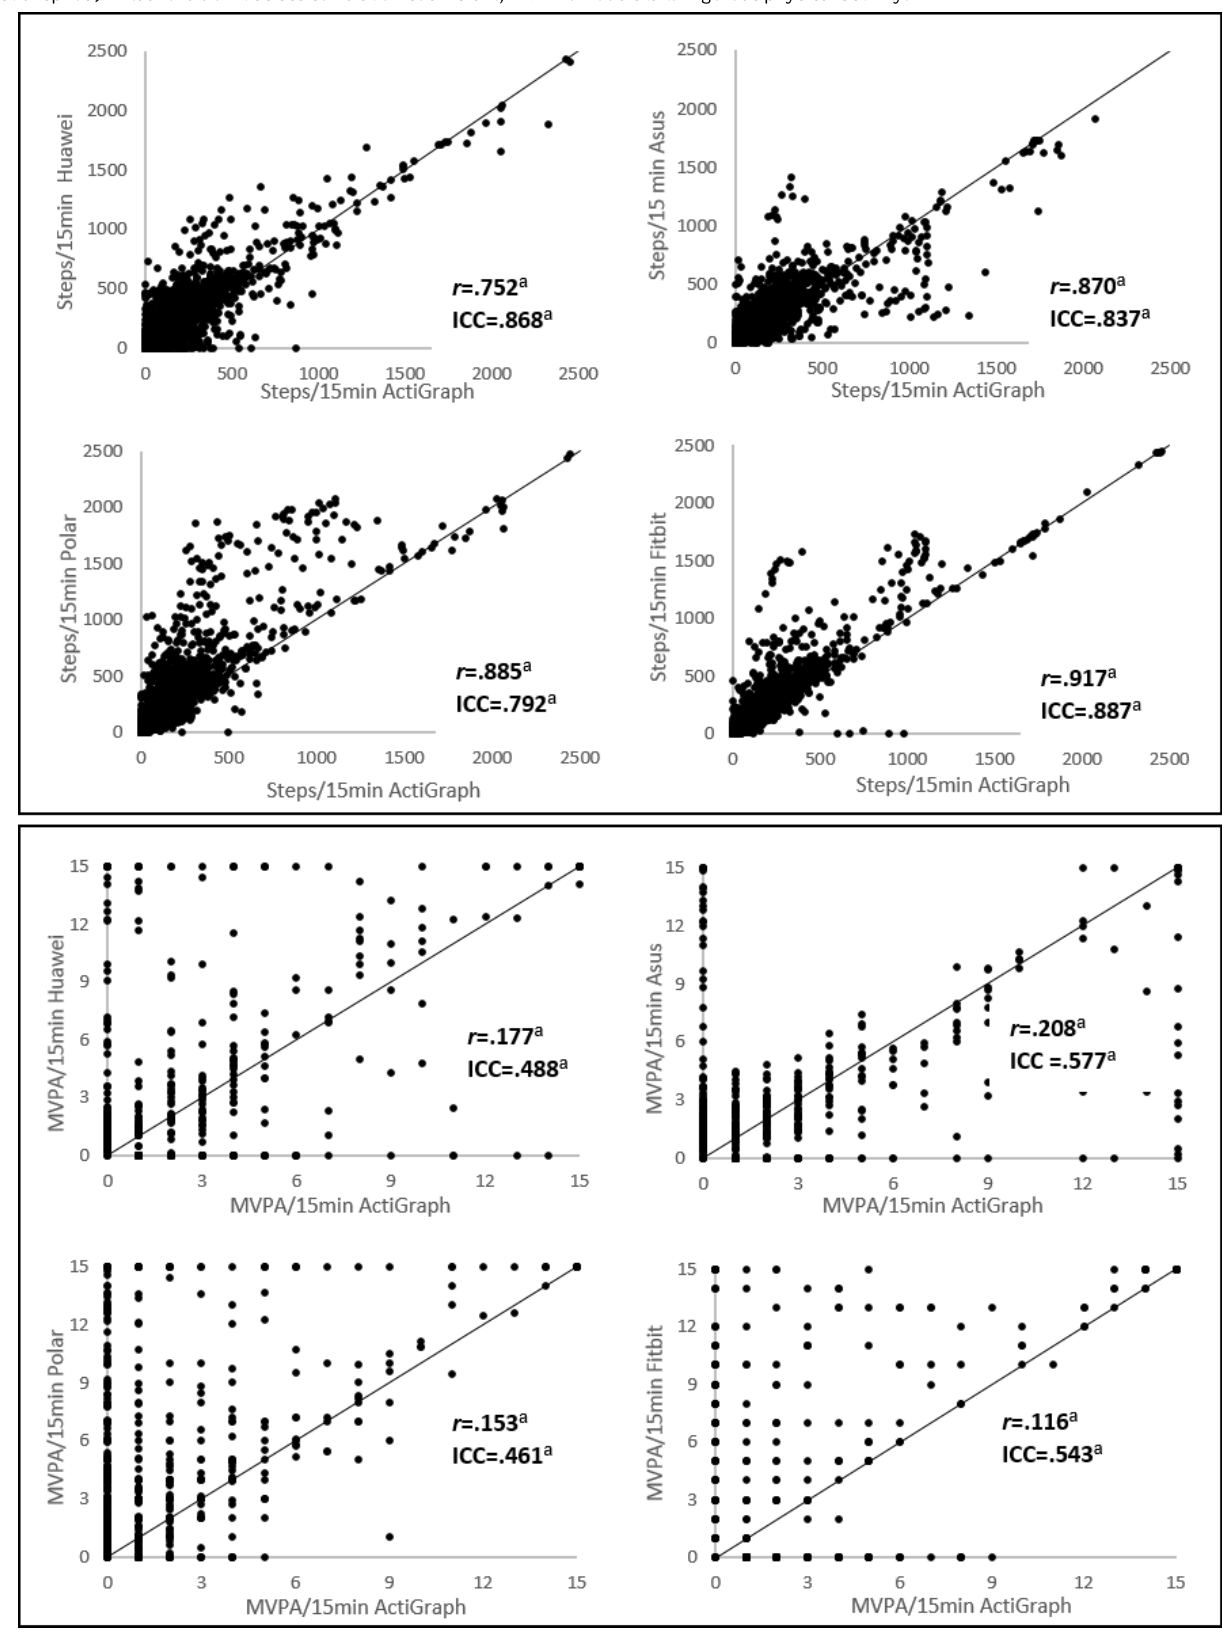
Figure 4. Correlations between the activity estimates per 15 min from the wearables and the ActiGraph GT3X+, Spearman r values, and intraclass correlation coefficient values that denote the correlation for measuring moderate to vigorous physical activity or steps between the wearables and the ActiGraph. a) P<.001. ICC: intraclass correlation coefficient; MVPA: moderate to vigorous physical